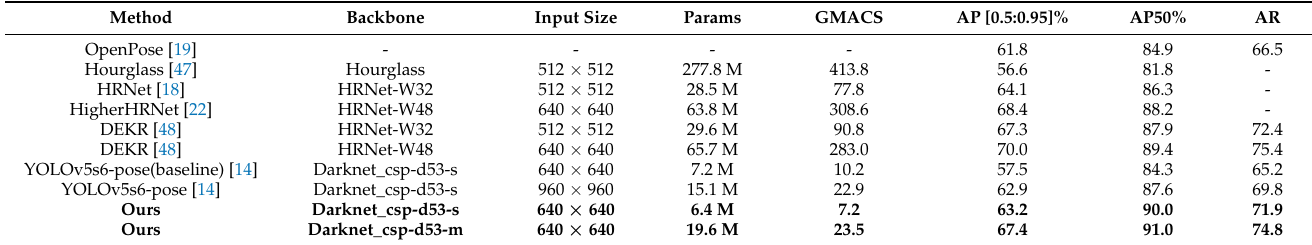
Table 2. Comparison of Accuracy of Different Methods on COCO